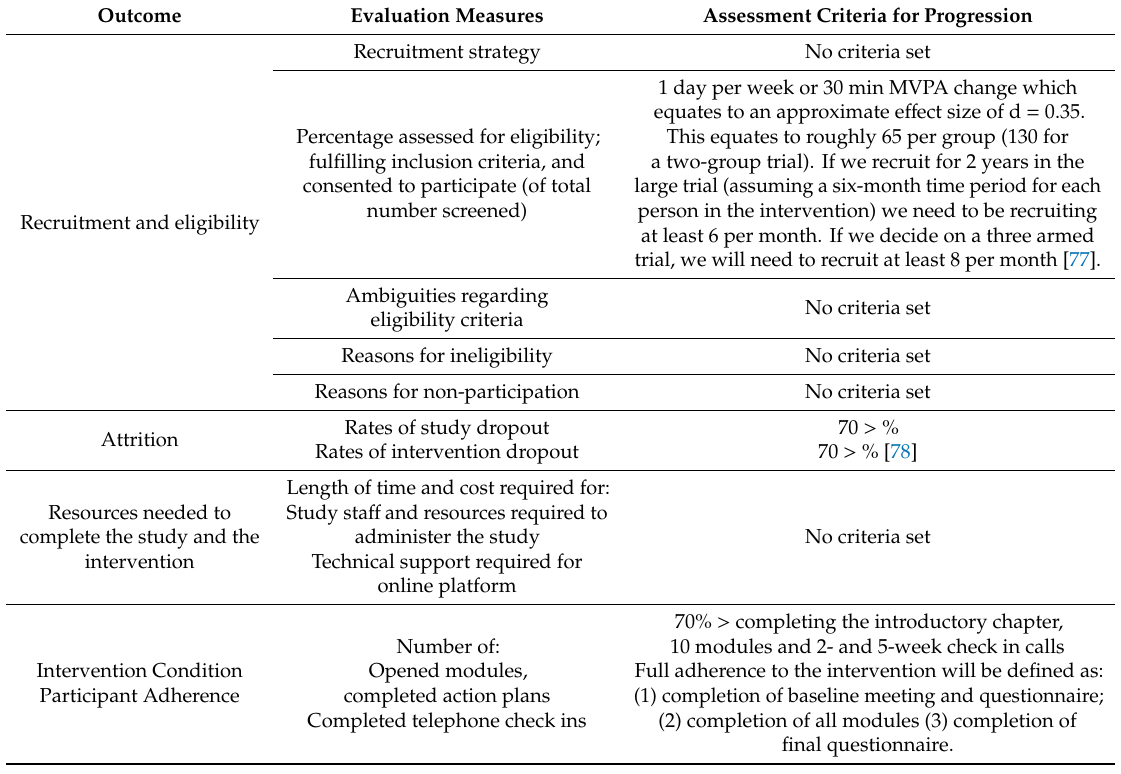
Table 2. Overview of feasibility outcomes and progression criteria, adapted from Woodford et al. (2018)